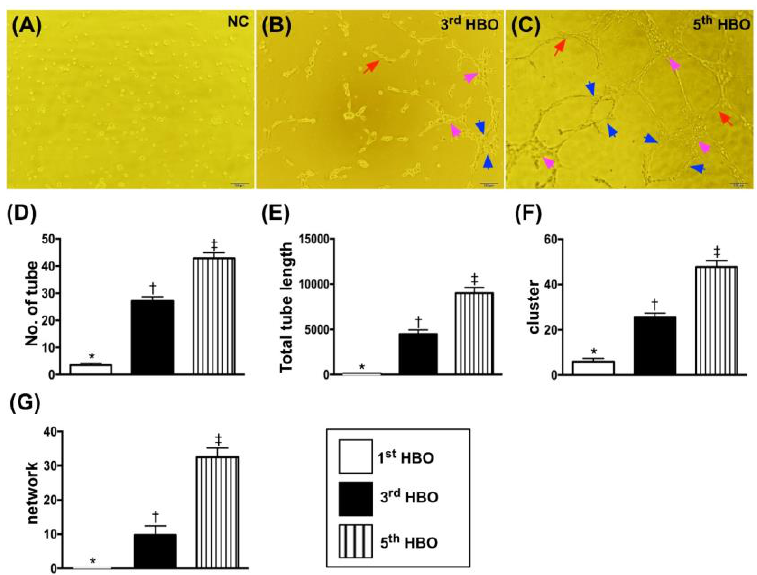
Figure 2. Matrigel assay for angiogenesis formation. ( A – C ) Illustrates the angiogenesis features of one patient prior to ( A ) and after the third ( B ) and fifth ( C ) sessions of HBO therapy, respectively. The angiogenesis was notably increased after the third session of HBO therapy and more notably increased after the fifth session of HBO therapy. The tubular (red arrows), cluster (pink arrows), and network (blue color) formations. ( D ) Number of tubule formations, *, vs. other groups with different symbols (†, ‡), p < 0.0001. ( E ) Tubule length, *, vs. other groups with different symbols (†, ‡), p < 0.0001. ( F ) Number of cluster formations, *, vs. other groups with different symbols (†, ‡), p < 0.0001. ( G ) Number of network formations, *, vs. other groups with different symbols (†, ‡), p < 0.0001. All statistical analyses were performed by one-way ANOVA, followed by Bonferroni multiple comparison post hoc test ( n = 10 patients). Symbols (*, †, ‡) indicate significance at the 0.05 level. “1st” indicates the blood sample was drawn prior to HBO therapy; “2nd” and “3rd” indicate the blood samples were drawn after the third and fifth sessions of HBO therapy, respectively.